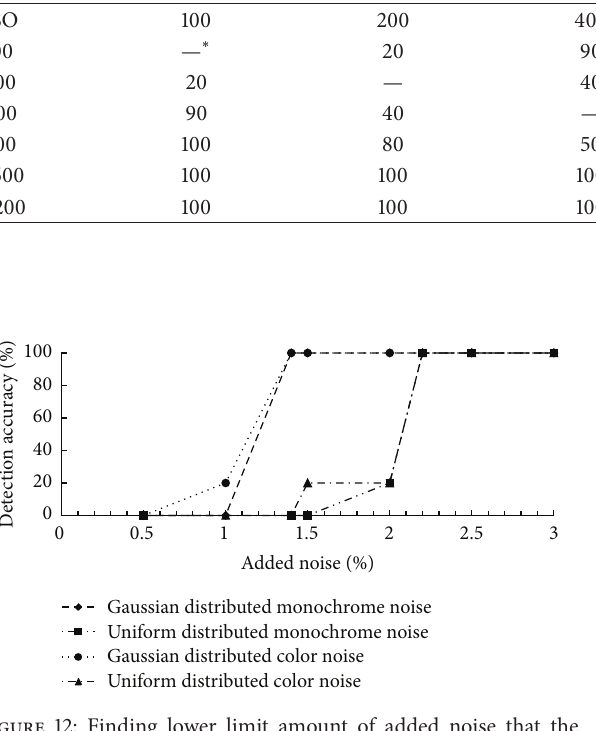
Figure 12: Finding lower limit amount of added noise that the algorithm can